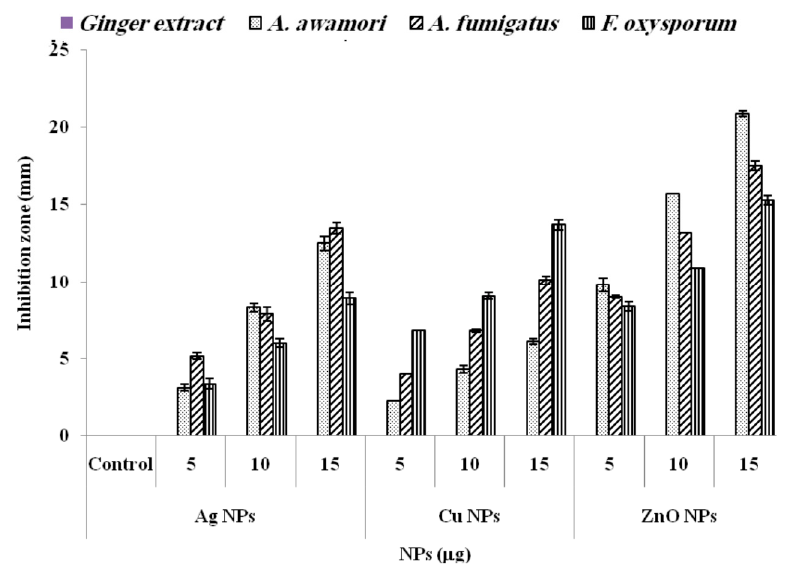
Figure 4. Zone of inhibition (ZOI) of AgNPs, CuNPs and ZnONPs against Aspergillus awamori JQ695830.1, A. fumigatus JX006238, and F.oxysporum FR11 treated with 5, 10, and 15 µg of AgNPs, CuNPs, and ZnONPs synthesized by aqueous extract of Zingiber officinale . Table 1. Minimum inhibition concentration (MIC) ± SD of AgNPs, CuNPs, and ZnONPs,